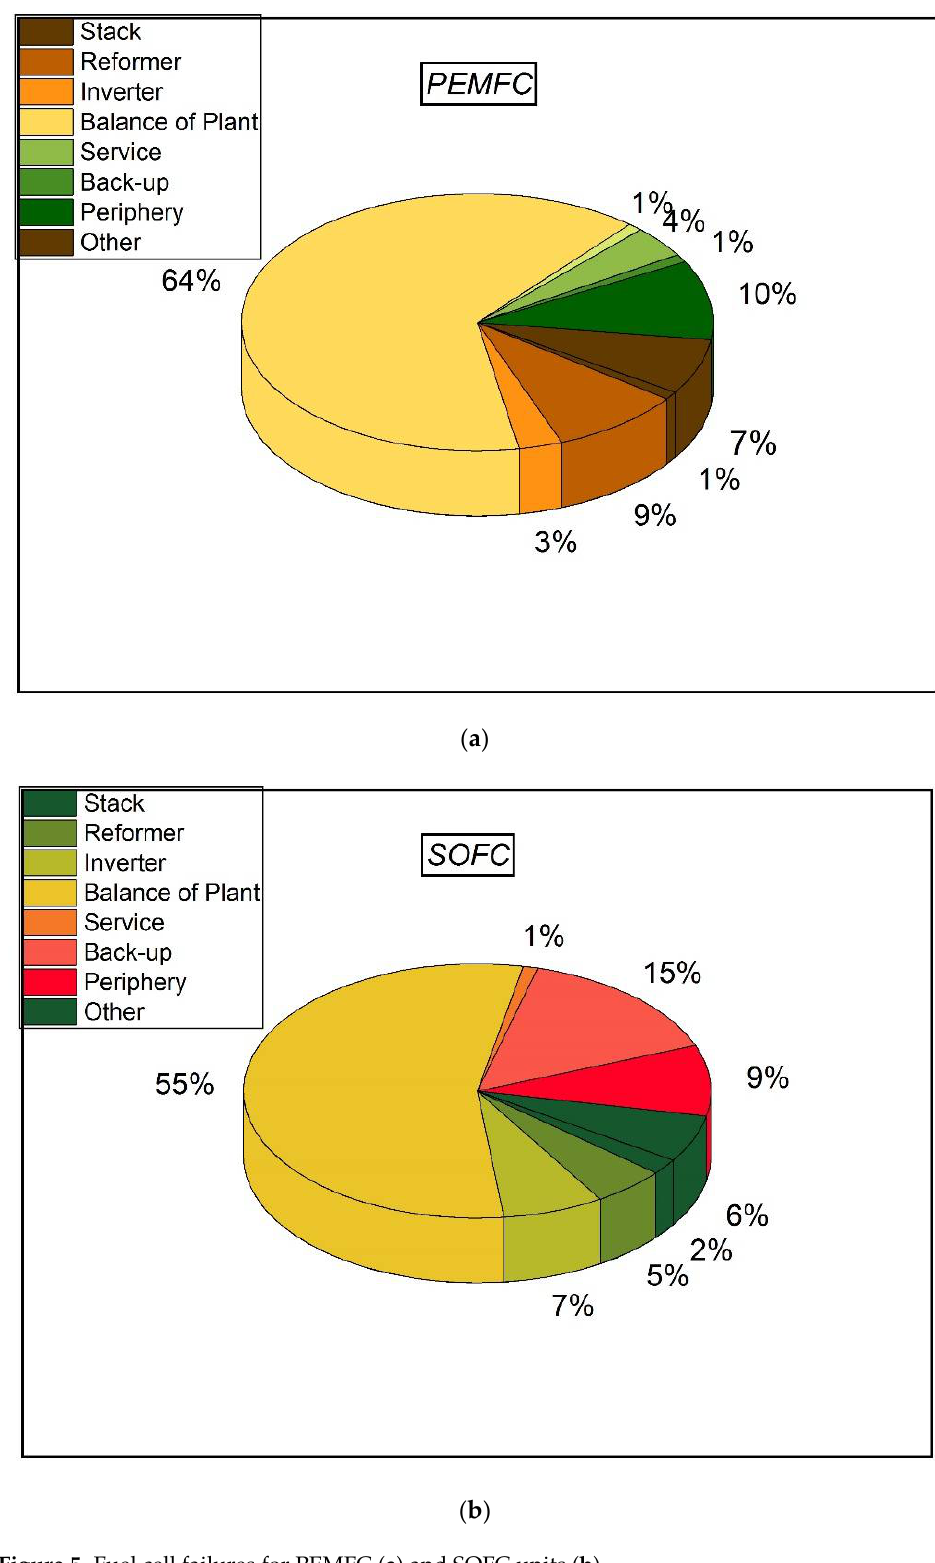
Figure 5. Fuel cell failures for PEMFC ( a ) and SOFC units ( b ).